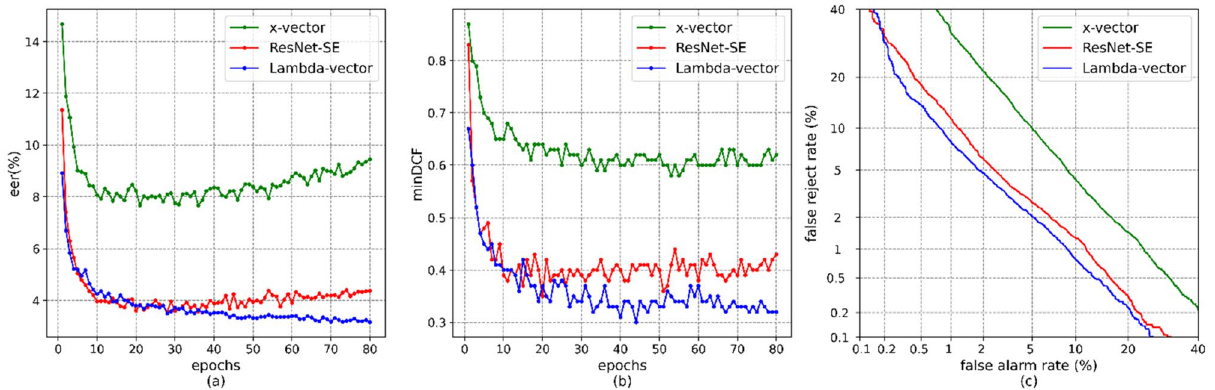
Figure 5. ( a ) EER changes with different training rounds. ( b ) minDCF changes with different training rounds. ( c ) The DET curve of the three models on Voxceleb1 test